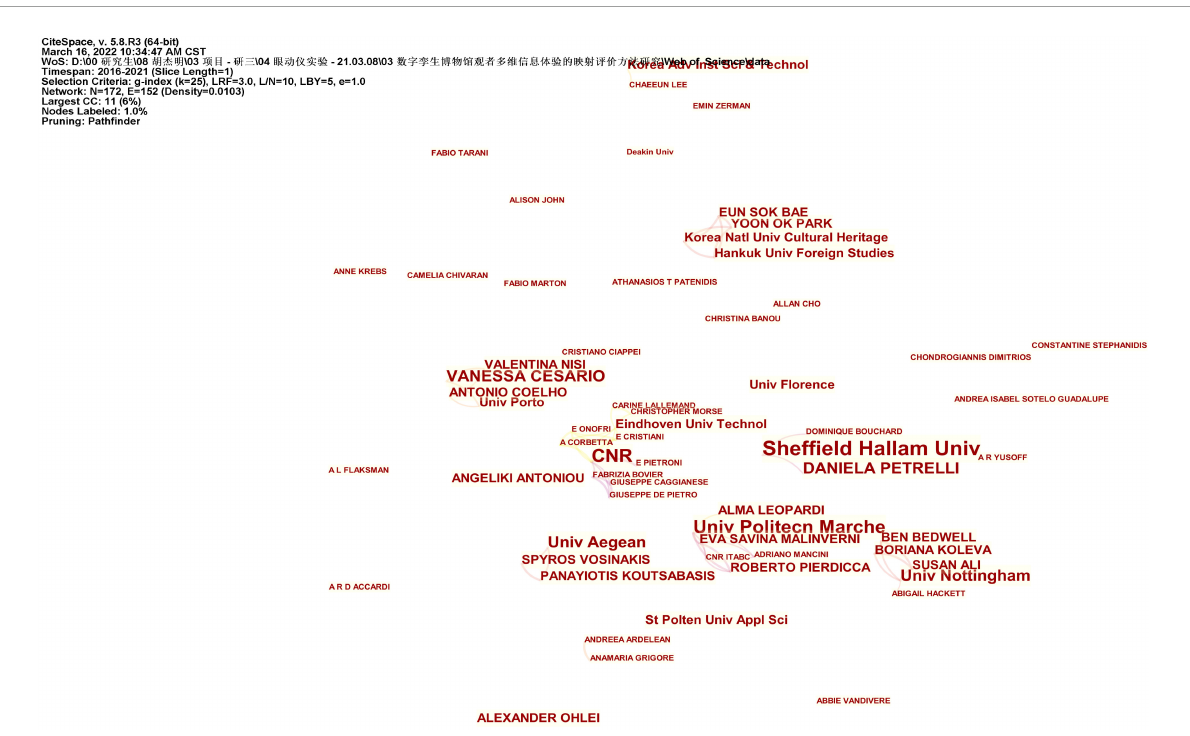
FIGURE1 Knowledge graph of relevant research institutions. Image source: The information was retrieved by our research team and exported after CiteSpace analysis. Data source: The authors were retrieved through Web of Science.